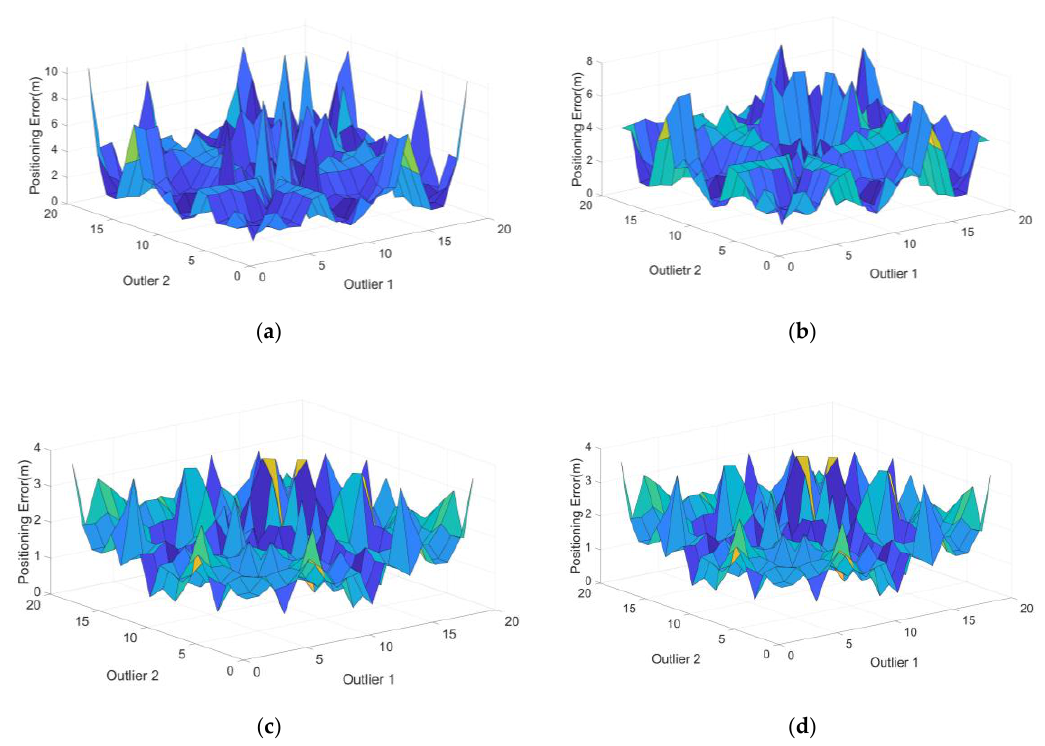
Figure 9. Positioning errors of four detectors for all combinations in Case 1: ( a ) detector 1, ( b ) detector 2, ( c ) detector 3 and ( d ) detector 4.